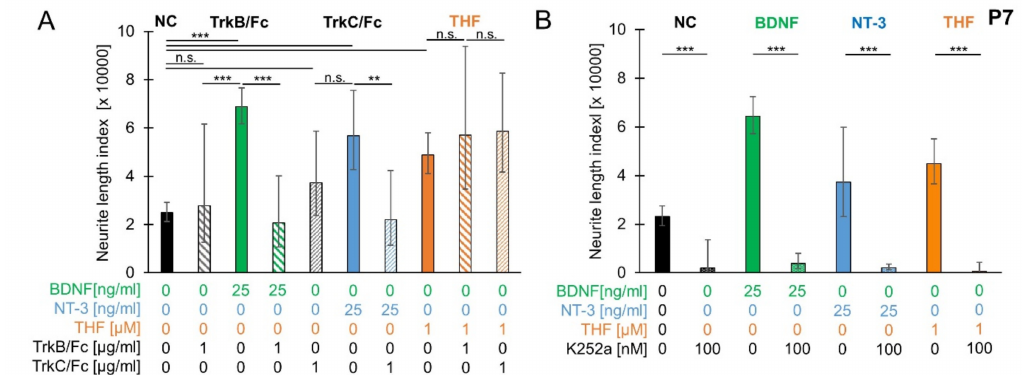
Figure 7. Trk receptor and ligand involvement in neurite outgrowth. ( A ) SGEs from P7 mouse cochlea were cultured in medium supplemented with 1 µ g / mL TrkB ligand scavengers (recombinant TrkB / Fc or TrkC / Fc), 25 ng / mL neurotrophin (BDNF or NT-3), or both scavenger and neurotrophin in combination. TrkB / Fc: TrkB / Fc was applied alone and simultaneously with BDNF. TrkC / Fc: TrkC / Fc was applied alone and simultaneously with NT-3. THF: 1 µ M THF was applied alone or in combination with either TrkB / Fc or TrkC / Fc. After 4 DIV, SGEs were fixed and stained for NF200. Neurite outgrowth was quantified. ( B ) P7 SGEs were cultured in medium supplemented with 100 nM K252a alone or with K252a and 25 ng / mL BDNF, 25 ng / mL NT-3, or 1 µ M THF. For comparison, compounds were applied alone and SGEs were cultured in medium devoid of neurotrophic supplements. After 4 DIV, SGEs were fixed and stained for NF200. Neurite outgrowth was quantified. Bars represent geometric means in µ m; error bars indicate ± upper and lower 95% confidence intervals for the mean; one-way ANOVA, Tukey–Kramer post-hoc test, n. s. = not significant ( p > 0.05), * p < 0.05, ** p < 0.01, *** p <